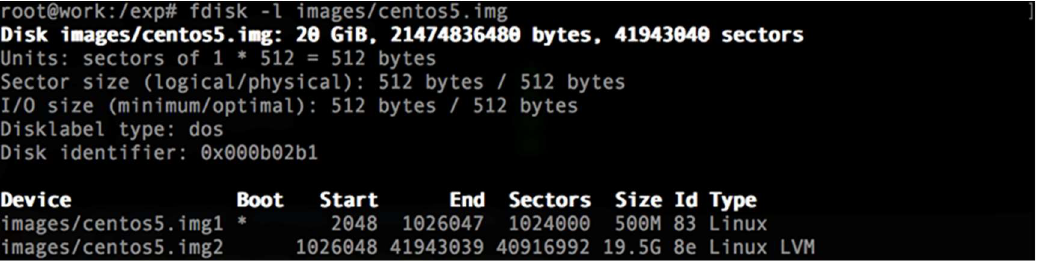
Figure 9. Partition of VM5.